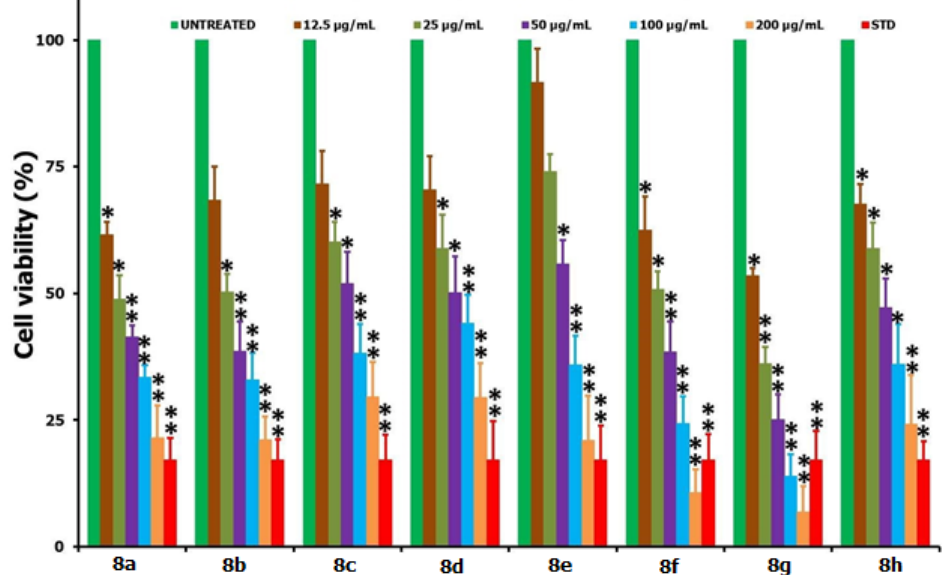
Figure 3. Cell viability comparison of MTT assay results of HepG2 cells from the treatment of compounds 8 ( a – h ) over a range of concentration (12.5–200 μ g/mL; 48 h period). From the figure, STD stands for melphalan (15 μ g/mL); * and ** relate to the significant ( p < 0.05) and highly significant ( p < 0.01) values as compared to those obtained with the untreated measurements.